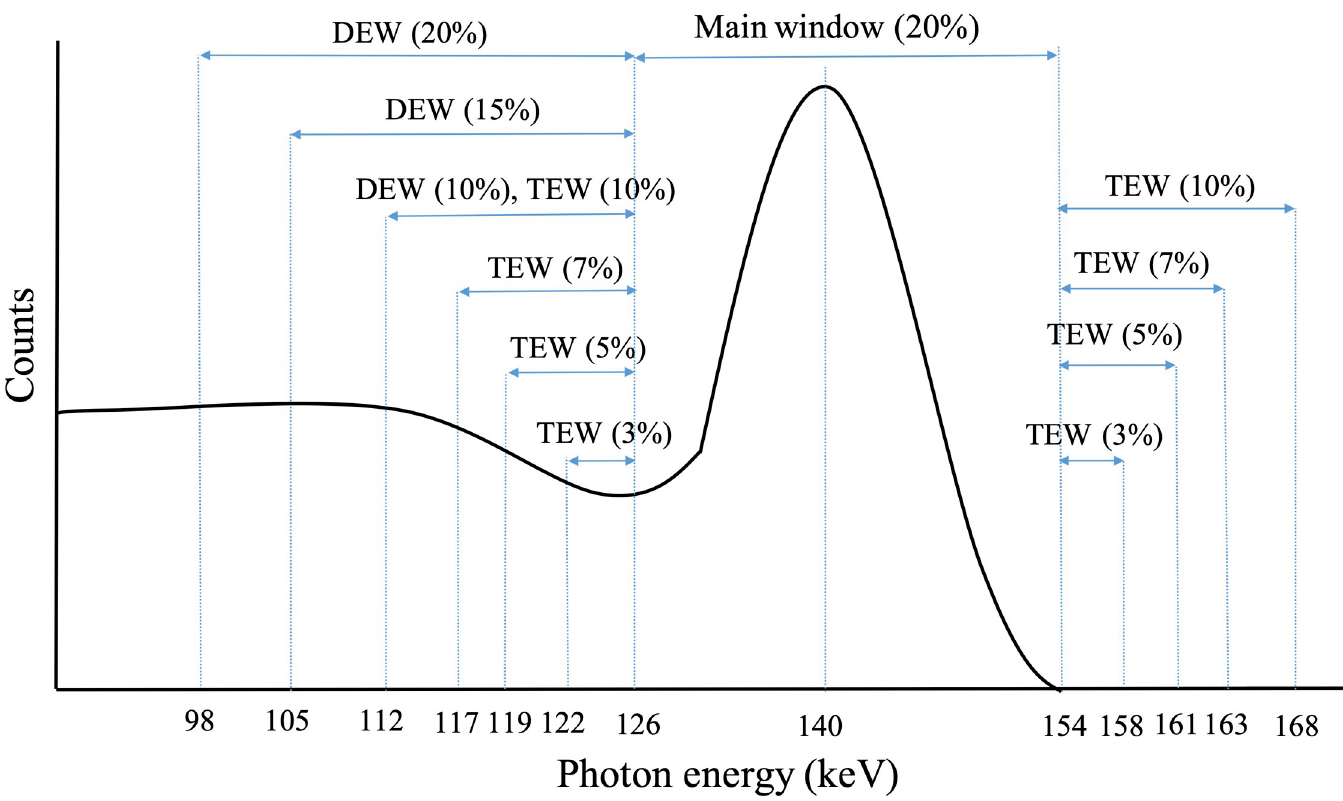
Fig 2. Acquired energy